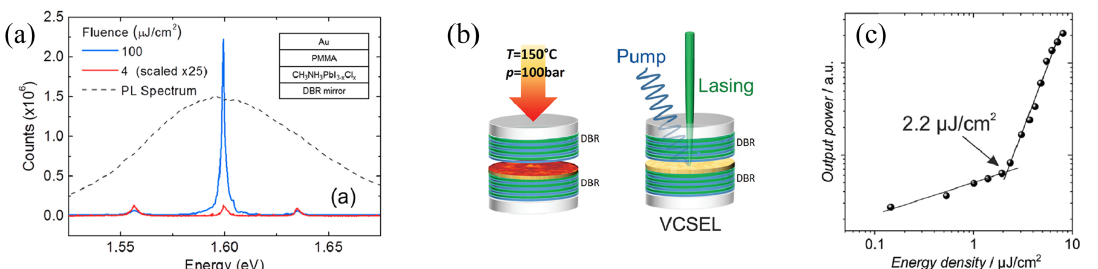
Figure 12. ( a ) Emission spectra of the MAPbI 3 − x Cl x and of the VCSEL below and above the lasing threshold. Inset: scheme of the cavity structure. Reproduced with permission from [6]. American Chemical Society, 2014. ( b ) Pictorial view of the CsPbBr 3 VCSEL realization by thermal